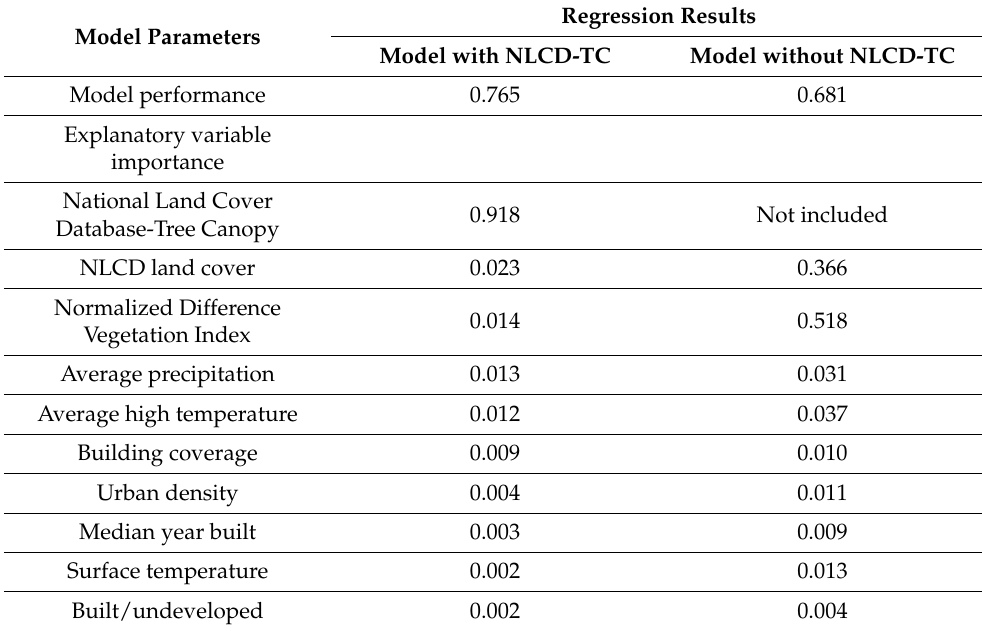
Table 2. Decision tree model outcomes (the importance/coefficient of explanatory variables).